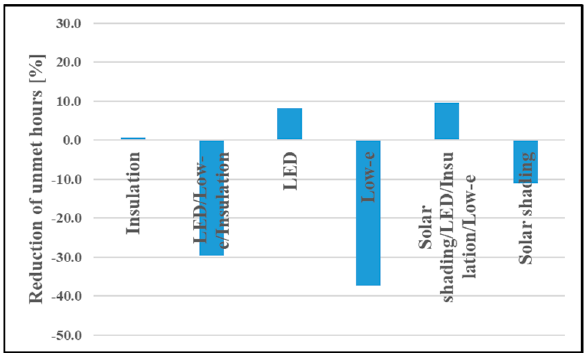
Figure 13. Reduction of hours outside ASHRAE 55 acceptability range.